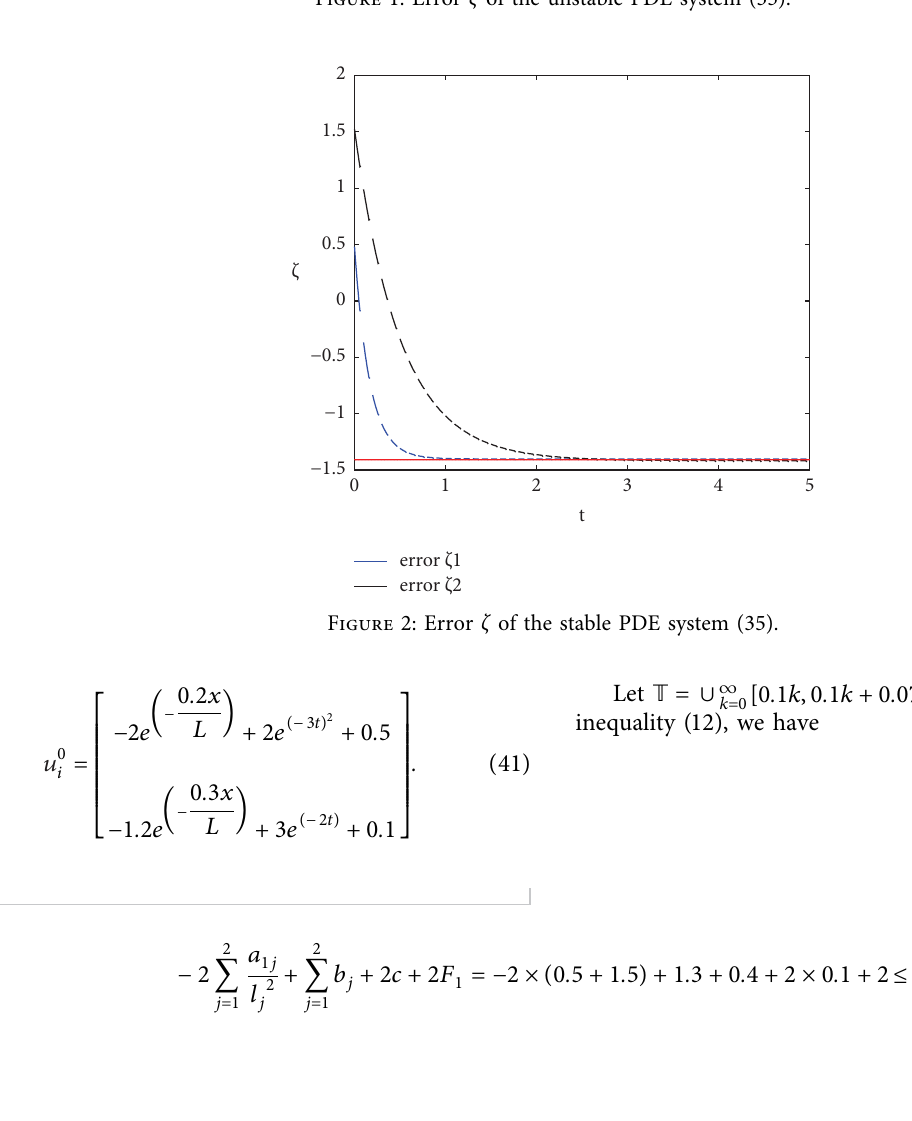
Figure 1: Error ζ of the unstable PDE system (35).